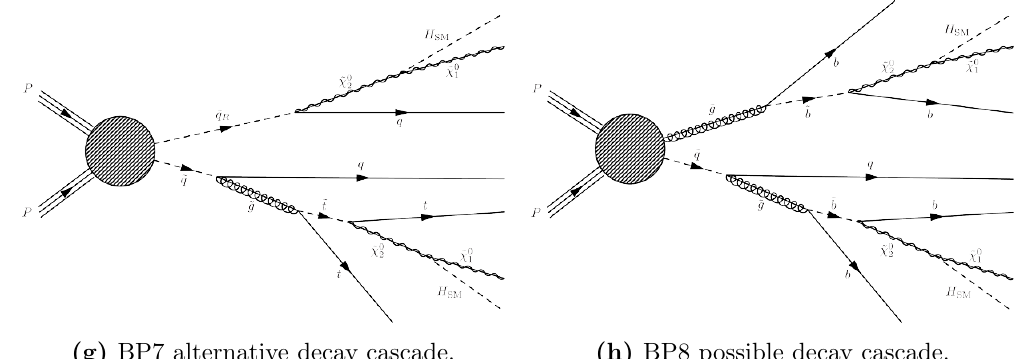
Figure 2. Feynman diagrams showing example processes by which we may produce two singlino LSP along with two Standard Model-like Higgs bosons. An example diagram is given for each of the BPs in [15] which contain unique mass hierarchies. Here, BP1, BP3, BP5, BP6, BP7 and BP8 are shown in (a), (b,c), (d), (e), (f,g) and (h),